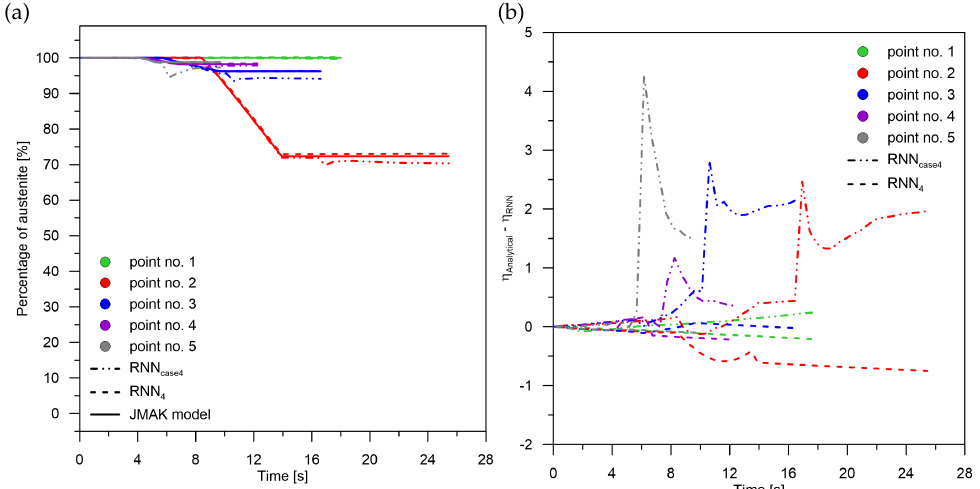
Figure 8. Phase transformation kinetics—case No. 4. ( a ) Phase transformation RNN 4 . ( b ) The difference between JMAK and RNN models.